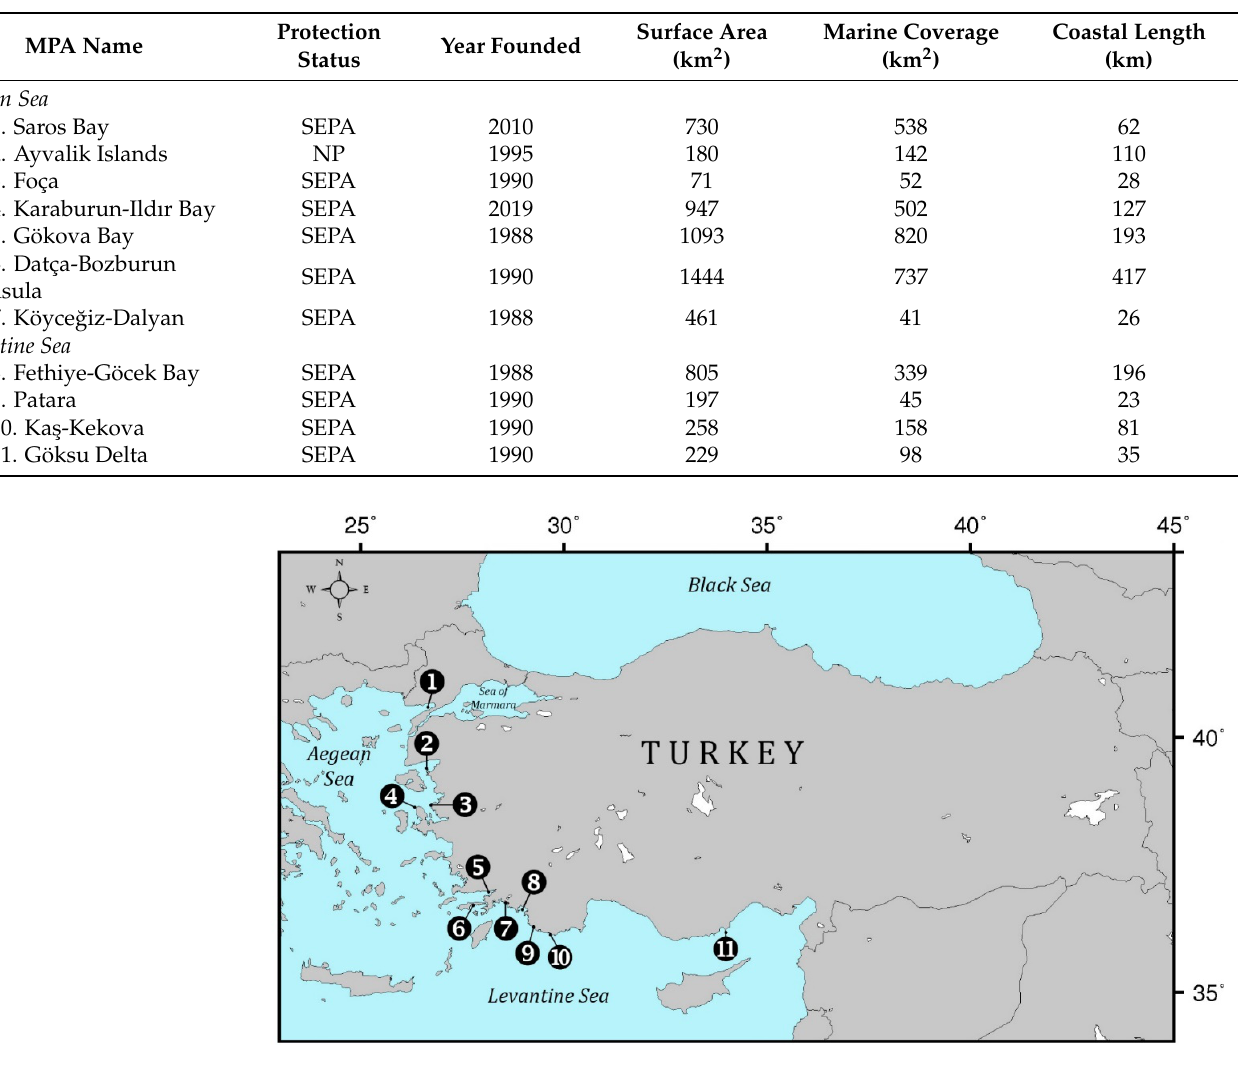
Figure 1. Geographical location of the studied MPAs (description of numerals as in Table 1).